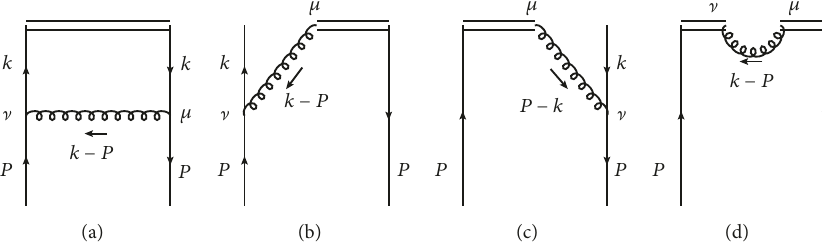
Figure 12: One-loop diagrams for the calculation of Green’s function of nonlocal operators. The double line represents the gauge link in the operator. Source: [180] (arXiv), reprinted with permission by the